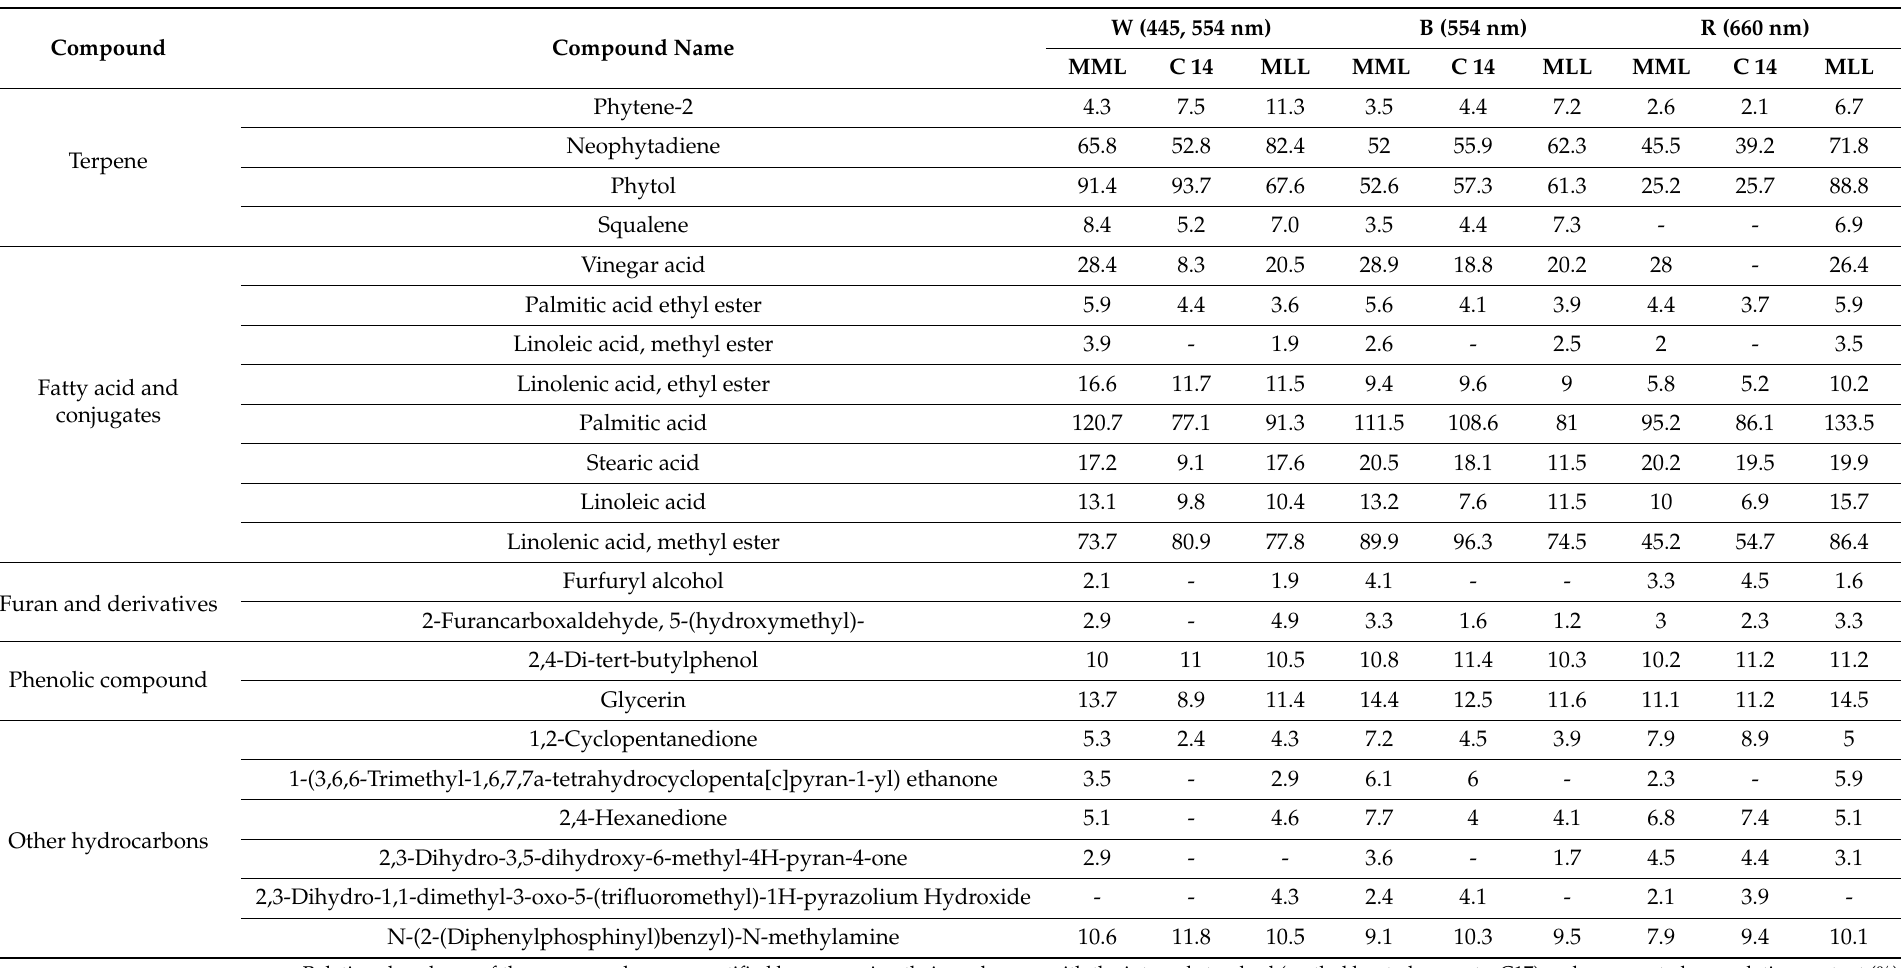
Table 4. Metabolic profiles of mulberry leaf extract analyzed by GC–MS. Three cultivars of mulberry (MML, C14, and MLL) were exposed to different light